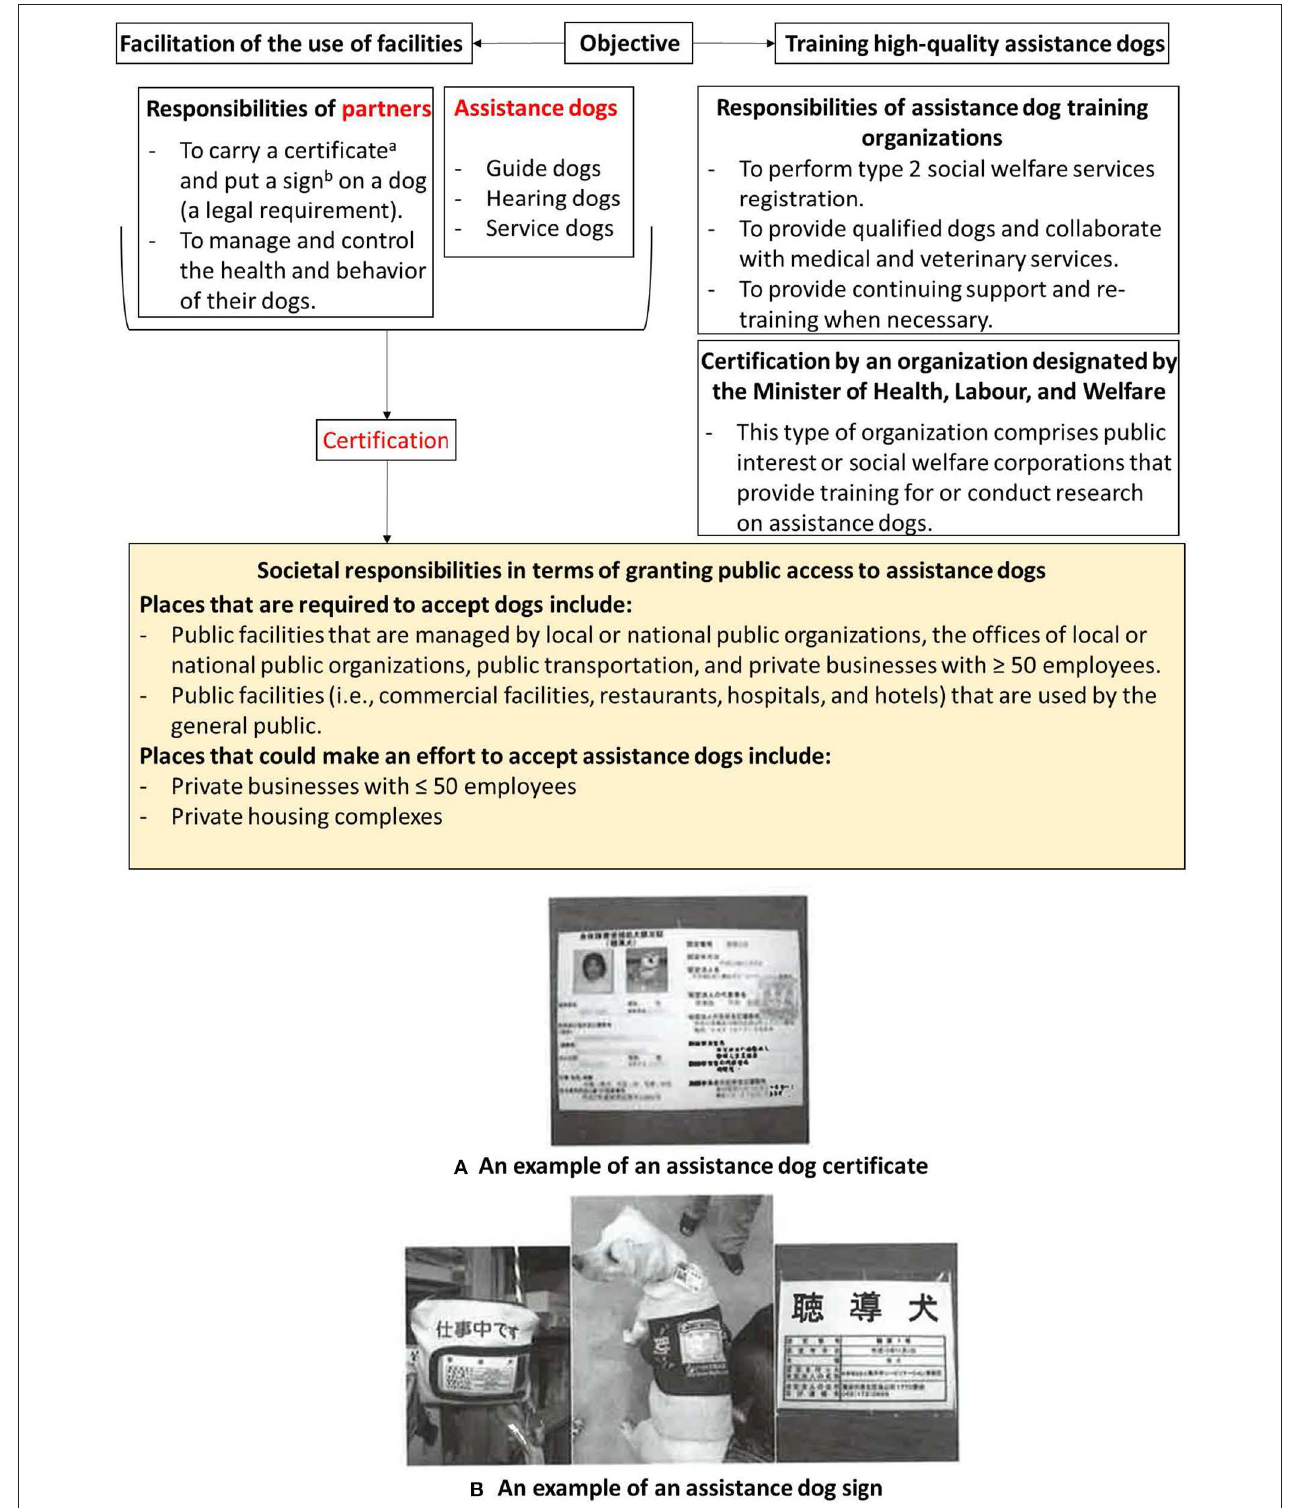
FIGURE 1 | Overview of the act on assistance dogs for physically disabled persons. (A) The assistance dog certificate shows photographs of the dog service partner and his or her assistance dog; the name, date of birth, address, and contact information of the service dog partner; the name, date of birth, breed, hair color,